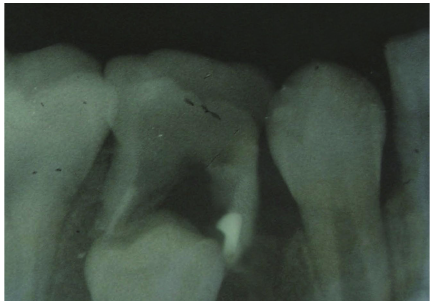
Figure 3: Intraoral periapical radiograph showing stapler pin in the pulp chamber of 11.